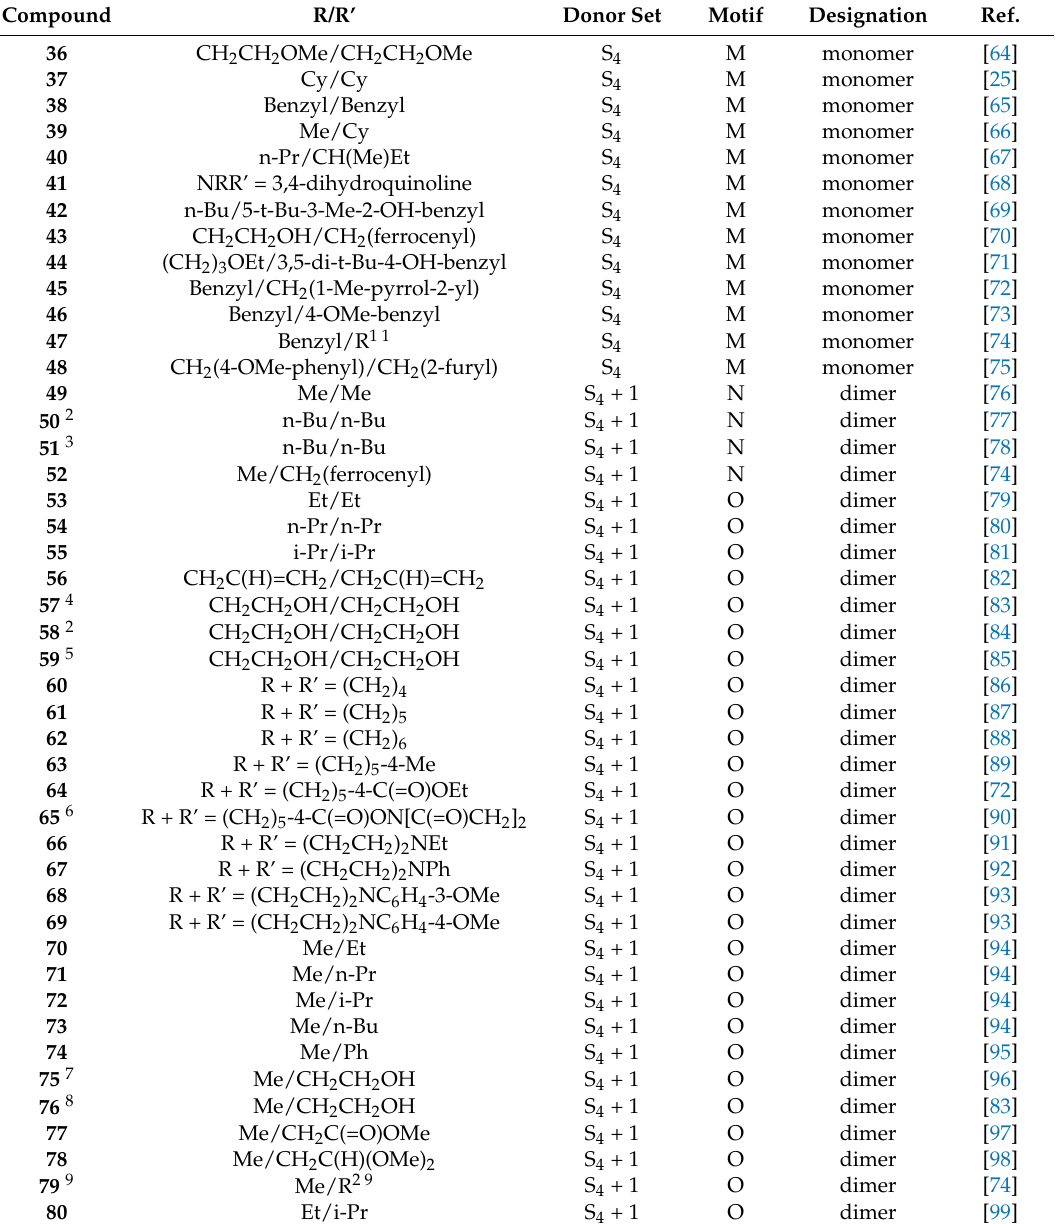
Table 3. Summary of the general features of Zn(S 2 CNRR’) 2 structures 36 – 100